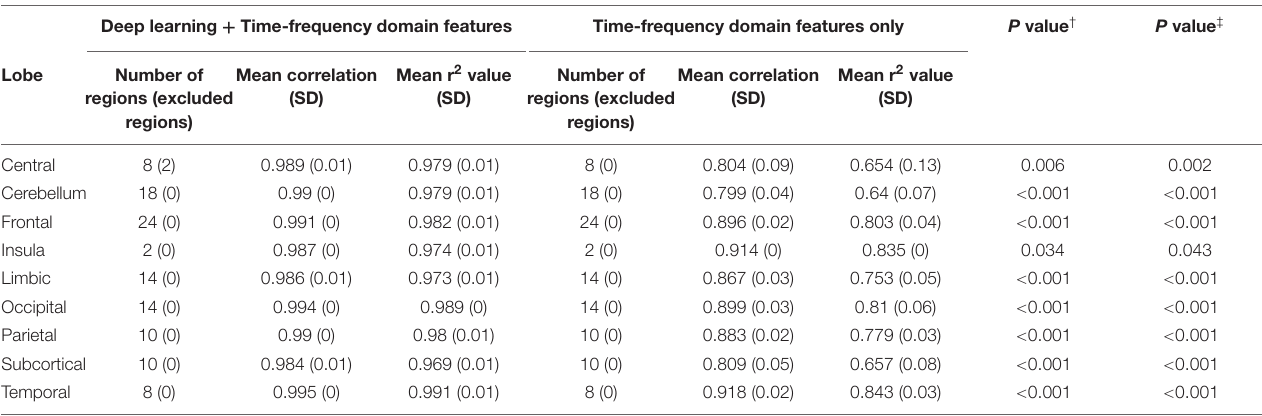
FIGURE 3 | Scatter plots of five regions with the highest correlation between the actual and estimated volumes. Five regions include the right superior/middle temporal gyrus, left inferior/middle temporal gyrus, and left middle occipital gyrus. For all subfigures, the y-axis represents the actual brain volume and the x-axis represents the estimated brain volume based on the linear regression model generated from the features extracted from the activity data. STG, superior temporal gyrus; MTG, middle temporal gyrus; MOG, middle occipital gyrus; ITG, inferior temporal gyrus; L/R, left/right hemisphere. TABLE 2 | Correlation between actual and expected volumes for each